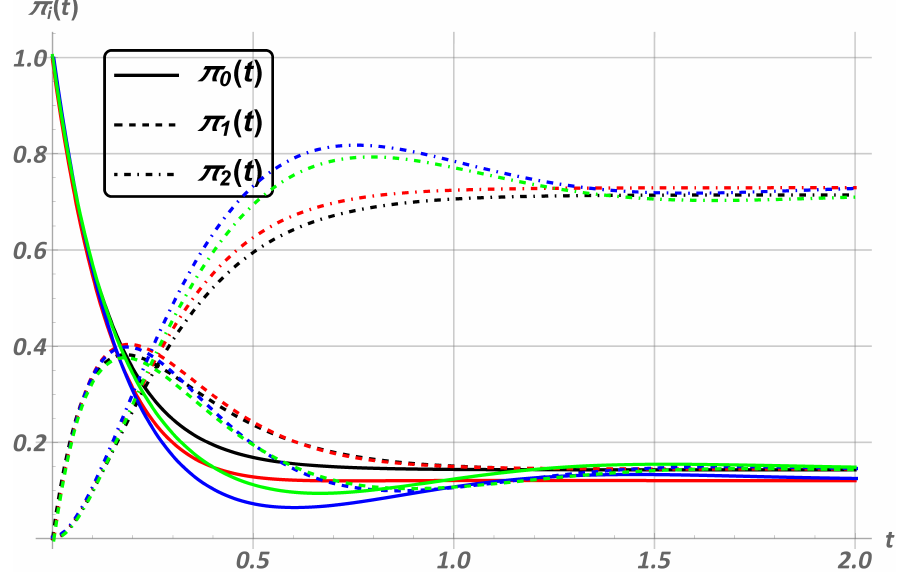
Figure 3. T.d.s.s.p.’s of (cid:104) M 2 < 6 | Erl | 1 (cid:105) system ( b = f = 1) with different values of coefficients of variation of components v b and system v f repair